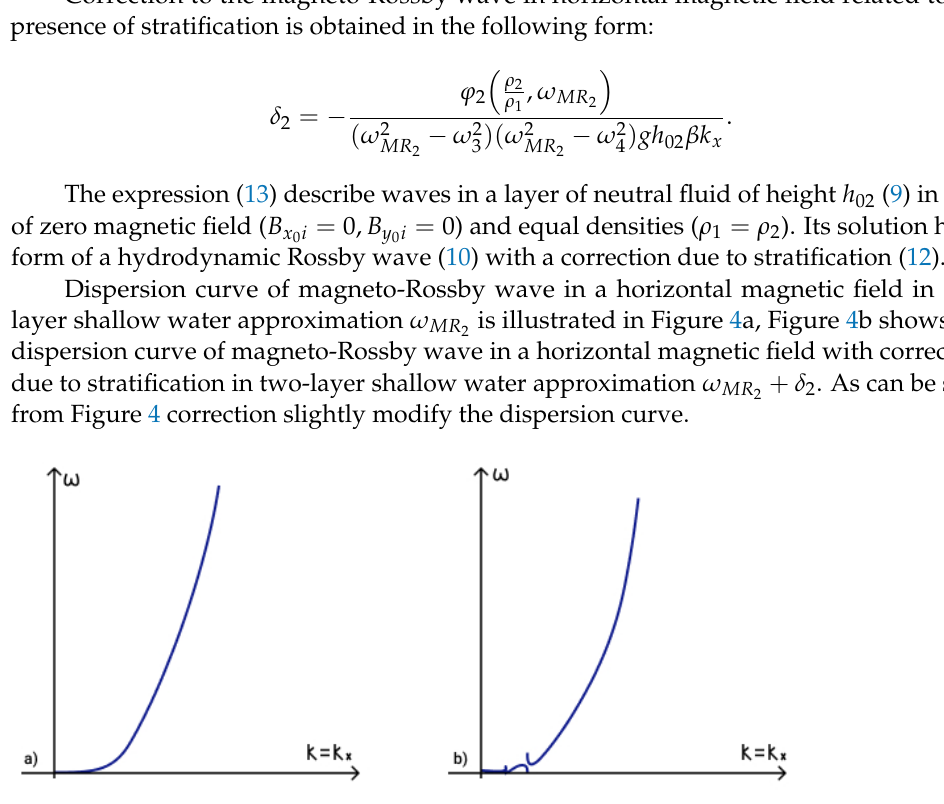
Figure 4. Dispersion curves of ( a ) magneto-Rossby wave in a horizontal magnetic field ω MR and ( b ) magneto-Rossby wave in a horizontal magnetic field with correction due to stratification + δ ω MR N 2